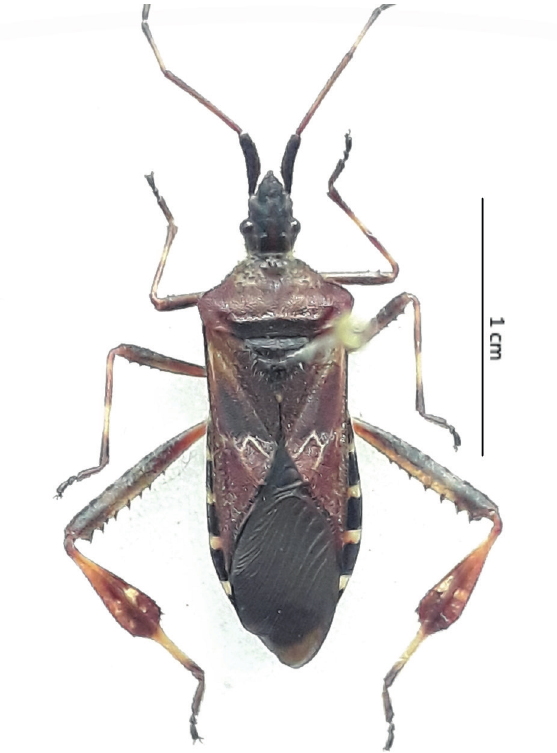
Figure 1 - Dorsal view of an adult of Leptoglossus occidentalis .